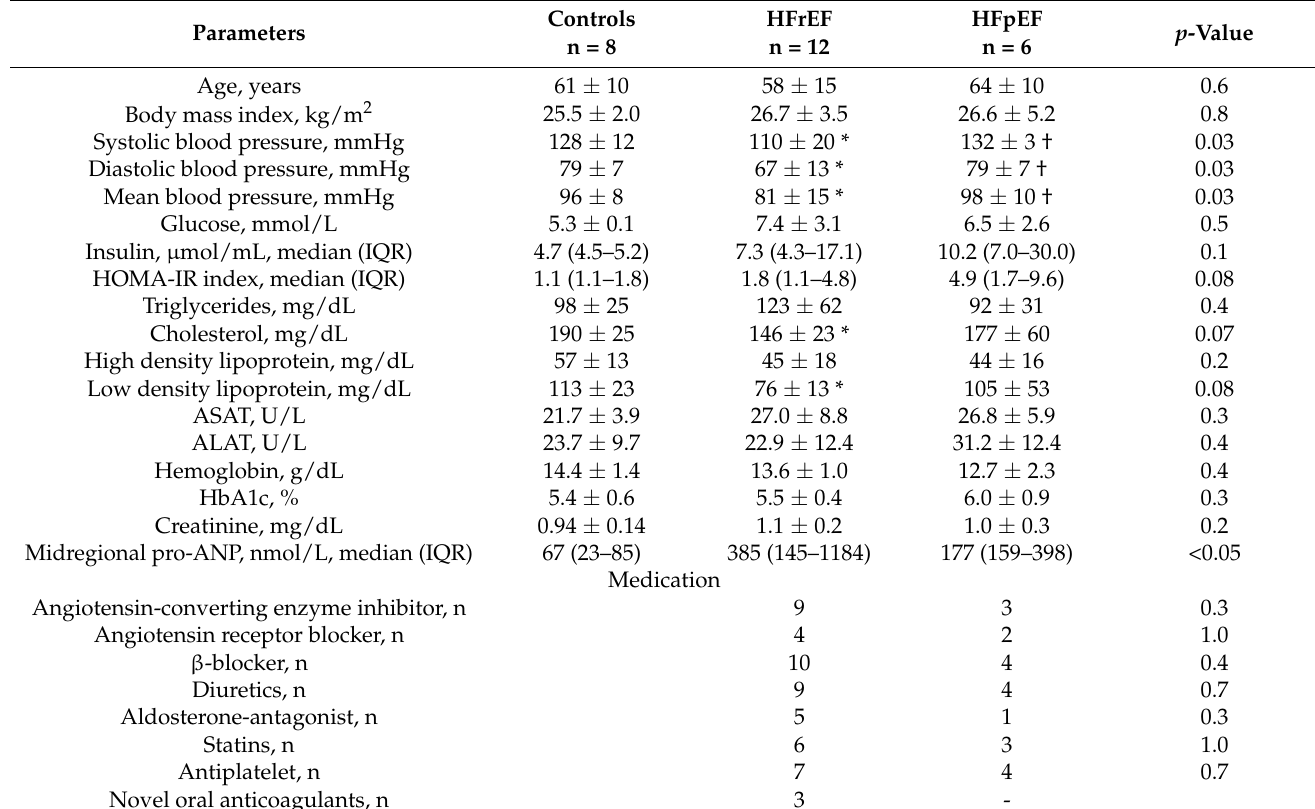
Table 1. Baseline clinical characteristics of study